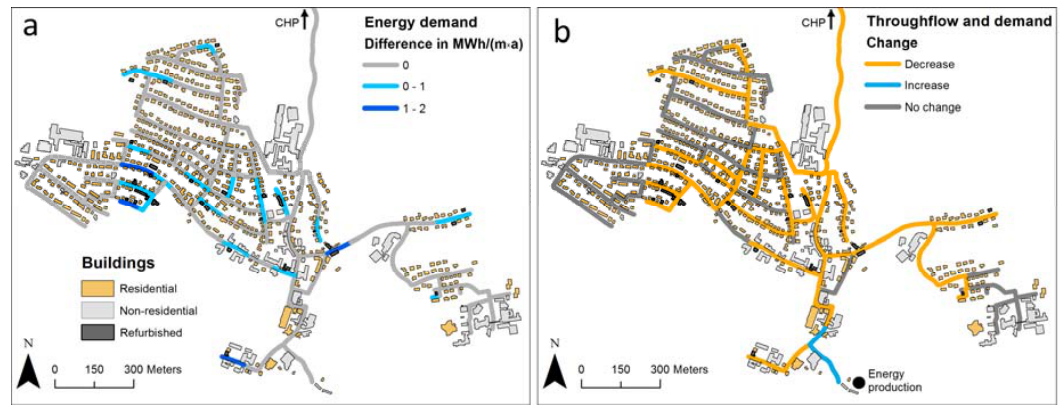
Figure 6. ( a ) The difference in energy demand between the simulated current condition (as shown in Figure 5a) and the scenario simulations; and ( b ) the difference in throughflow and demand.